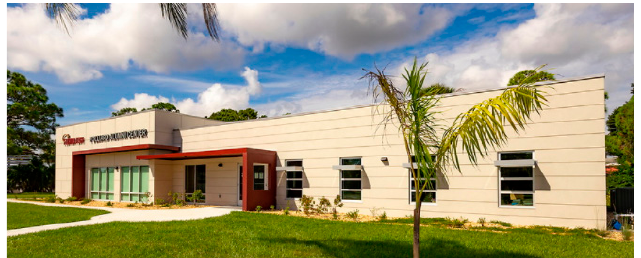
Figure 1. Florida Tech Alumni Center (building used for the case study).